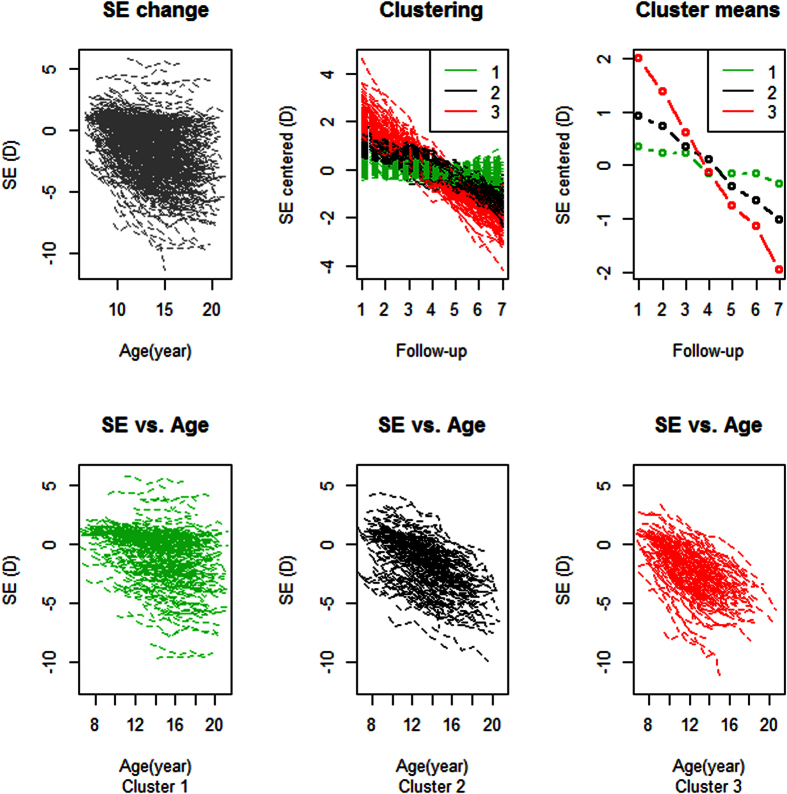
Partitioning clustering of longitudinal refraction in first-born twins.Upper left: refraction change over age in right eyes of all subjects. Upper middle: three clusters of progressing pattern. Upper right: The medoids in the three clusters. Lower row shows that the distributions of cluster 1 to 3 with age respectively.